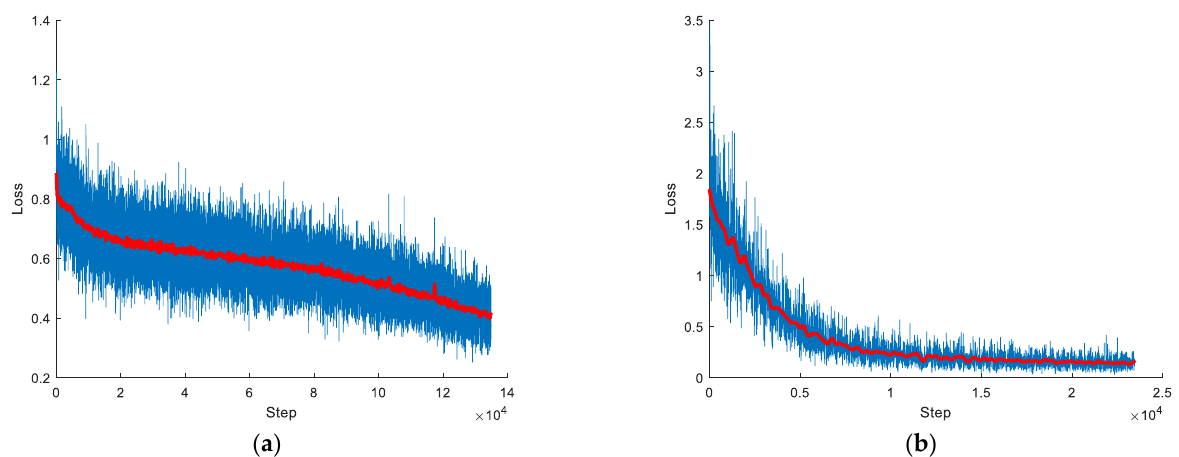
Figure 17. Train result (under the condition of trial 1): ( a ) loss of “sequence to sequence” model; ( b ) loss of “image to sequence” model.